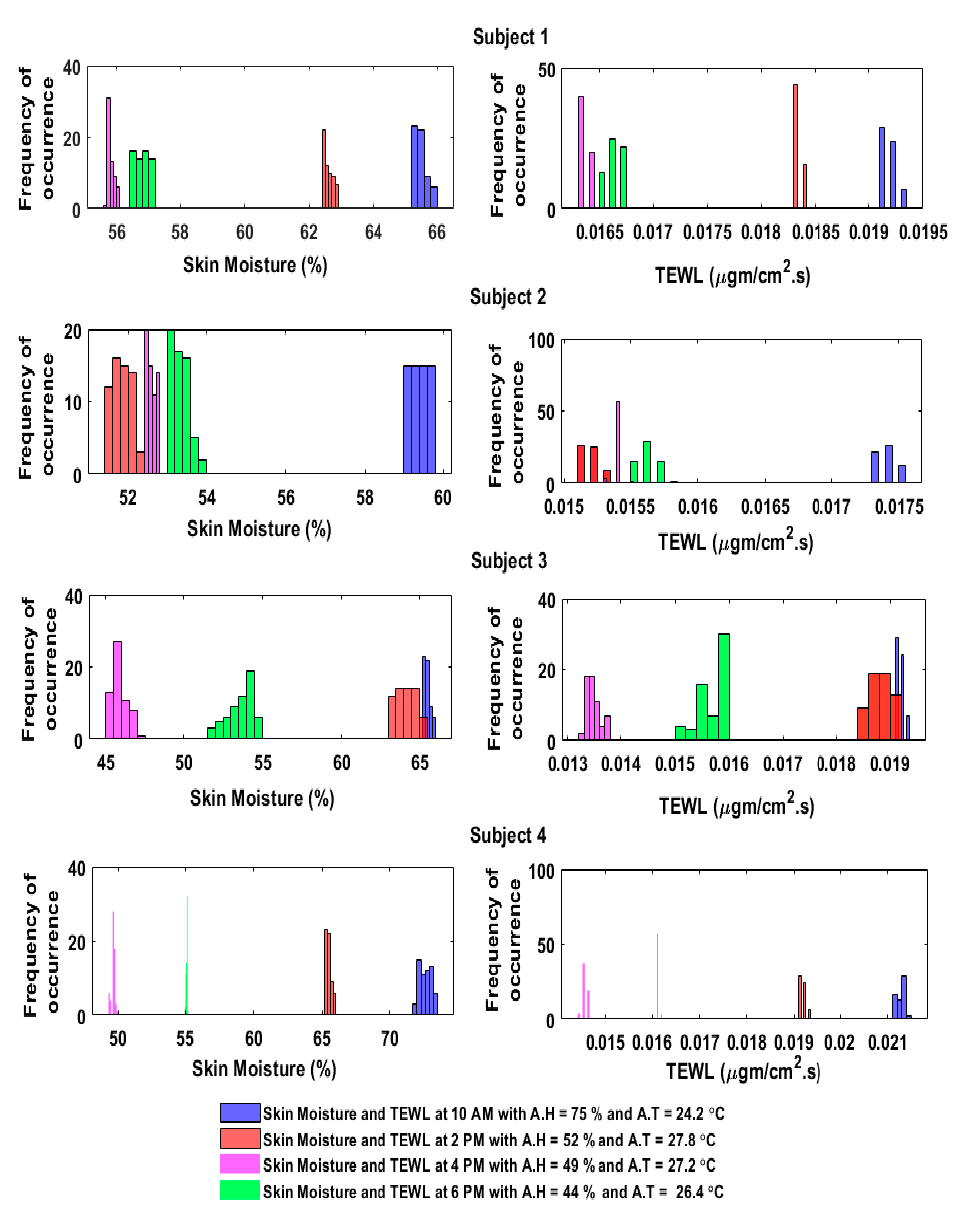
Figure 9. Histogram relationship between the skin moisture and the TEWL in the indoor environment.